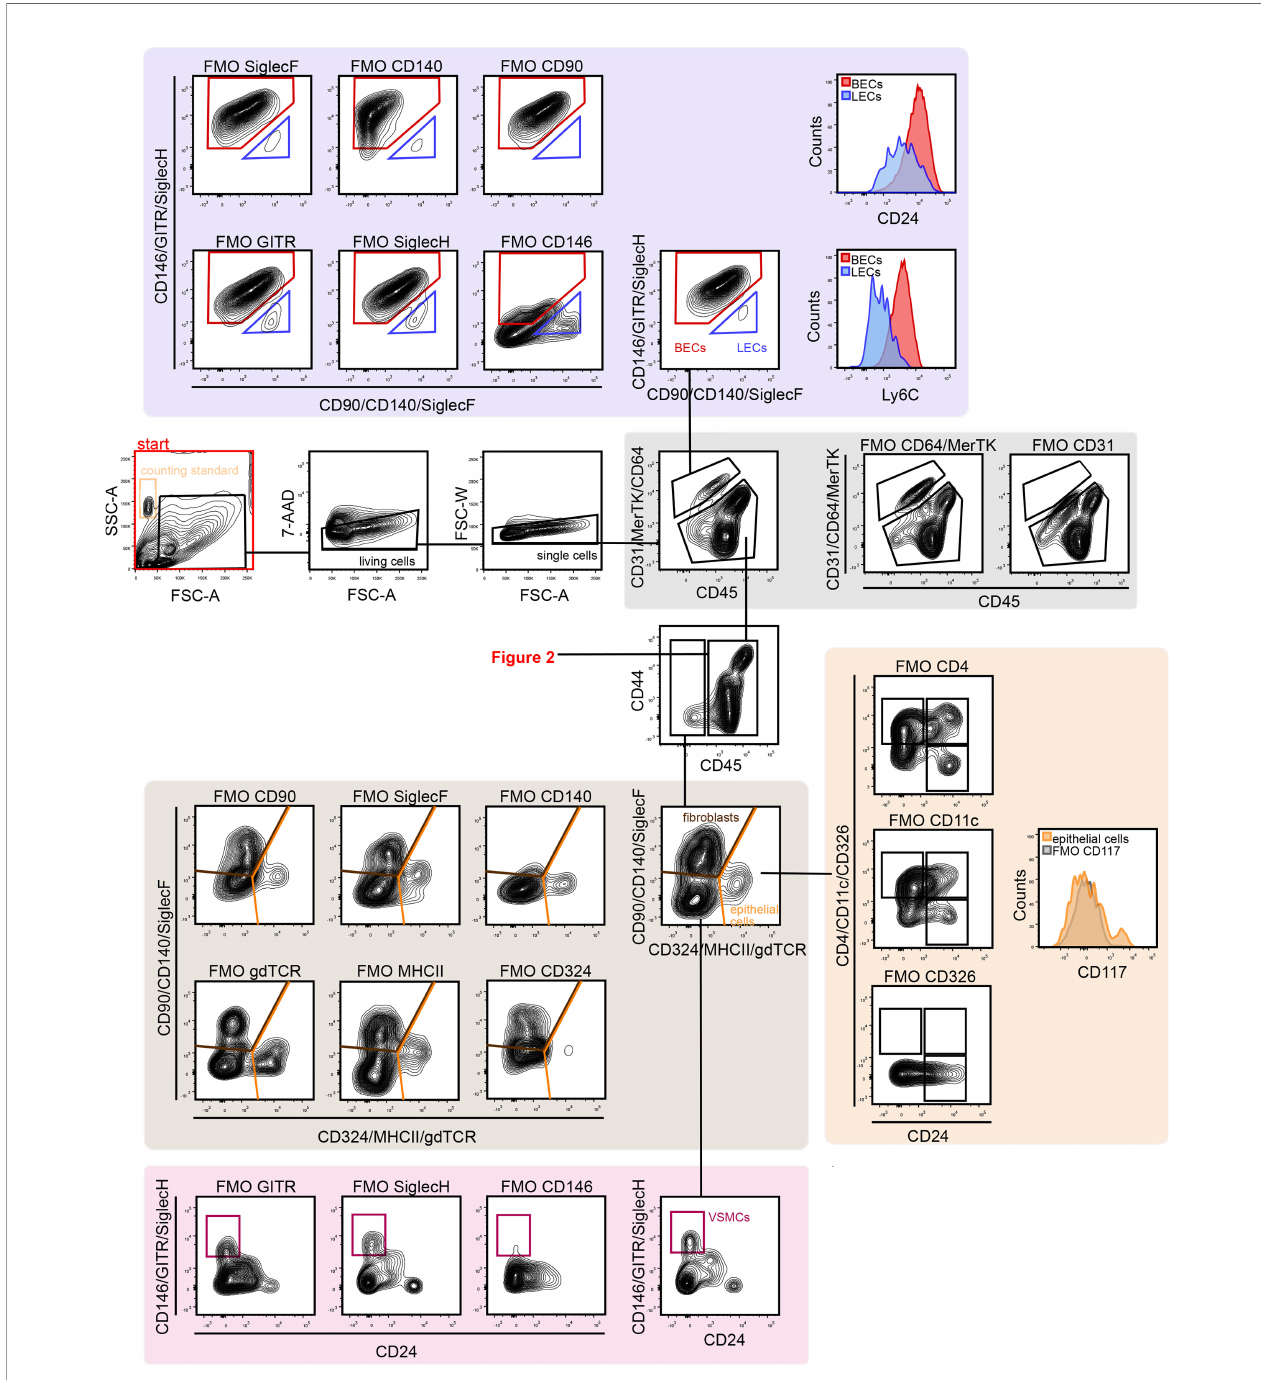
FIGURE 1 | Gating strategy for lung vascular, epithelial and stromal cells. First, FSC, SSC, and 7-AAD gating was conducted to remove debris, dead cells, and cell clumps. Next, vascular cells were separated from other lung cells by CD31 and CD45 gating. CD31 + cells are vascular endothelial cells, which can be separated into BECs (CD146 + Ly6C + ) and LECs (CD90 + CD146 - ). CD45 + cells are immune cells (see Figure 2 ). The CD31 – /CD45 – population included fi broblasts (CD140 + / CD324 – ) and epithelial cells (CD324 + /CD140 – ). The CD324 – /CD140 – population included CD146 + VSMCs. 7-AAD, 7-aminoactinomycin D; BECs, blood endothelial cells; FMO, fl uorescent minus one; FSC-A, forward scatter area; FSC-W, forward scatter width; LECs, lymphatic endothelial cells; SSC, side scatter; VSMCs, vascular smooth muscle